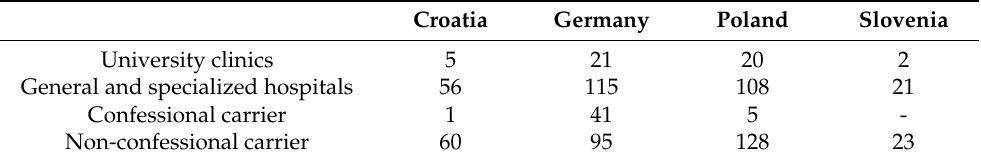
Table 1. Categories with numbers of hospitals in each country to which the request was